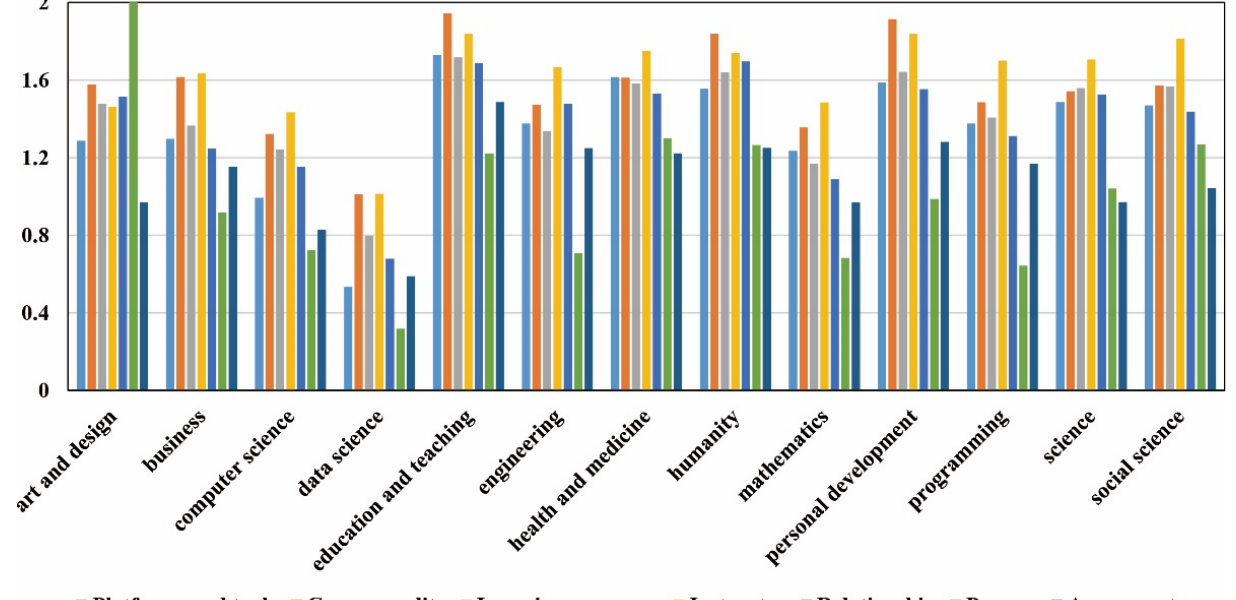
Figure 9. Averaged scores calculated based on averaged sentiment scores of “syuzhet”, “bing”, “afinn”, and